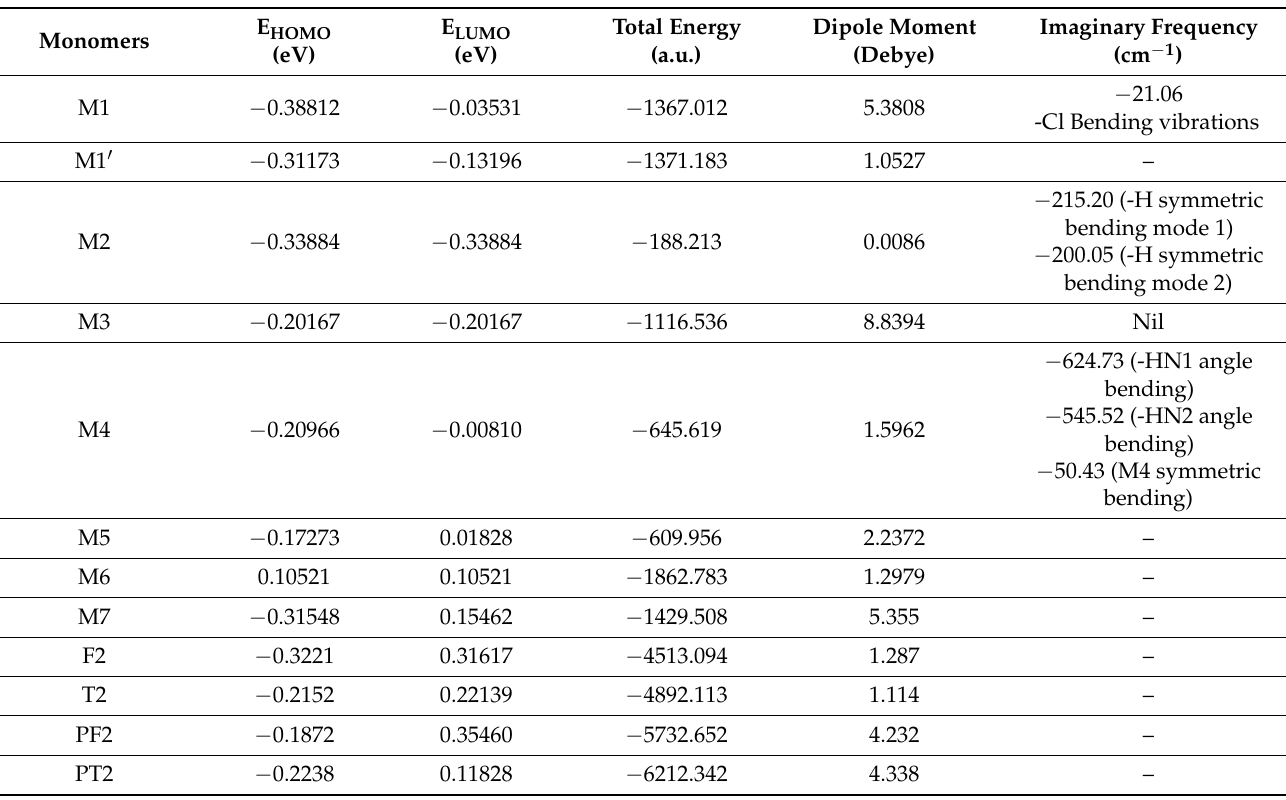
Table 4. Computed electronic parameters, polarity, and vibrational energies of monomers